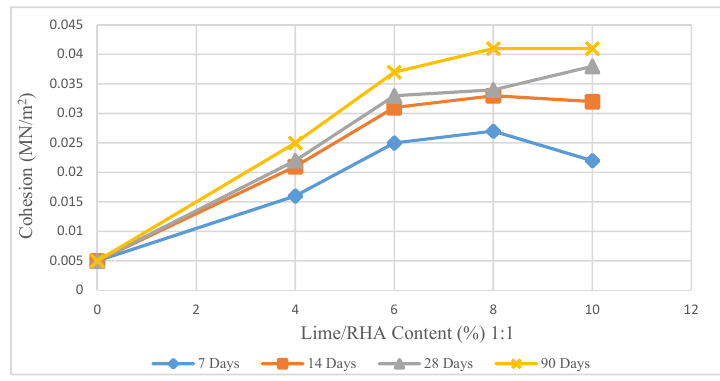
11 of 16 Figure 9. Shear stress to horizontal strains diagram—LRHA 1:2 (vertical stress 0.5 MPa). The strain data accumulated from six tests, obtained from untreated soil and samples treated with LRHA in the lower level (4%) after 7 days curing, showed lower shear stress values than those treated with higher levels of LRHA and longer curing duration. A sim-